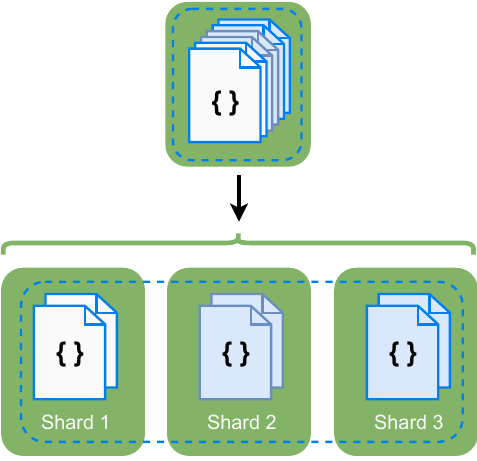
Figure 3. Sharding